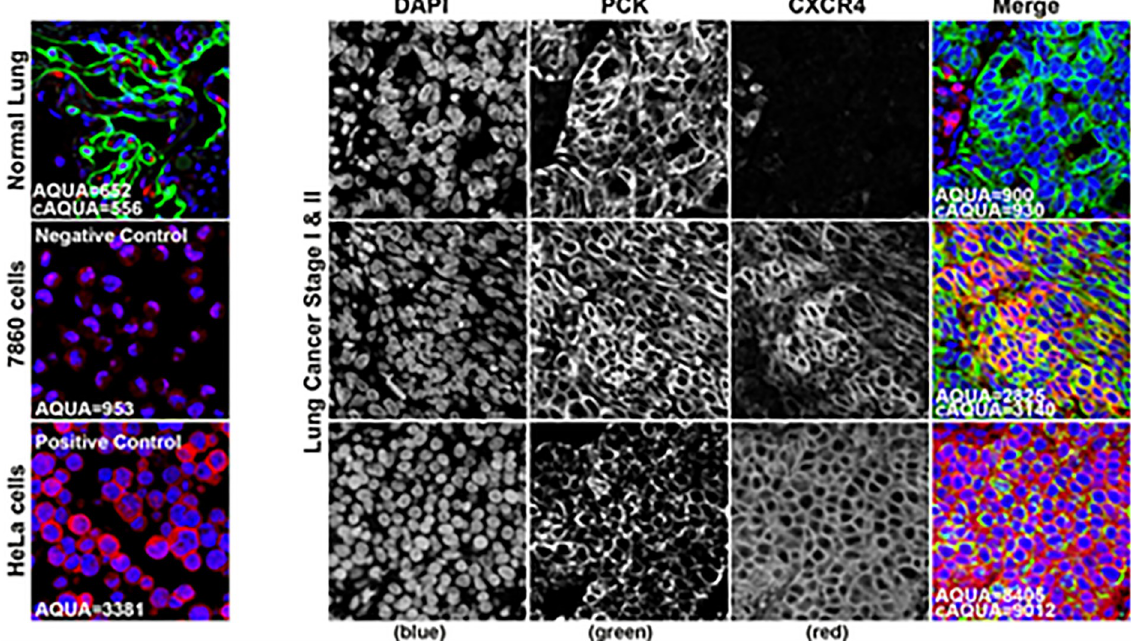
Fig 1. CXCR4 immunohistochemical (IHC) staining. CXCR4 expression in negative and positive (HeLa) control cells (left panel). CXCR4 staining in early stage non-small cell lung cancer patients, with low (right top panel) and high CXCR4 expression (right bottom panel) shown in red. DAPI nuclear staining shown in blue, and PCK tumor cytosolic component shown in green.